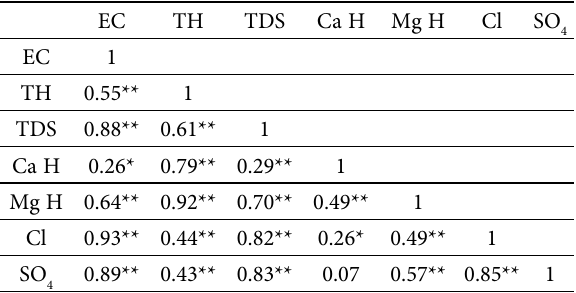
Table 3. Correlation between general parameters analyzed in leachate samples ( n = 81)